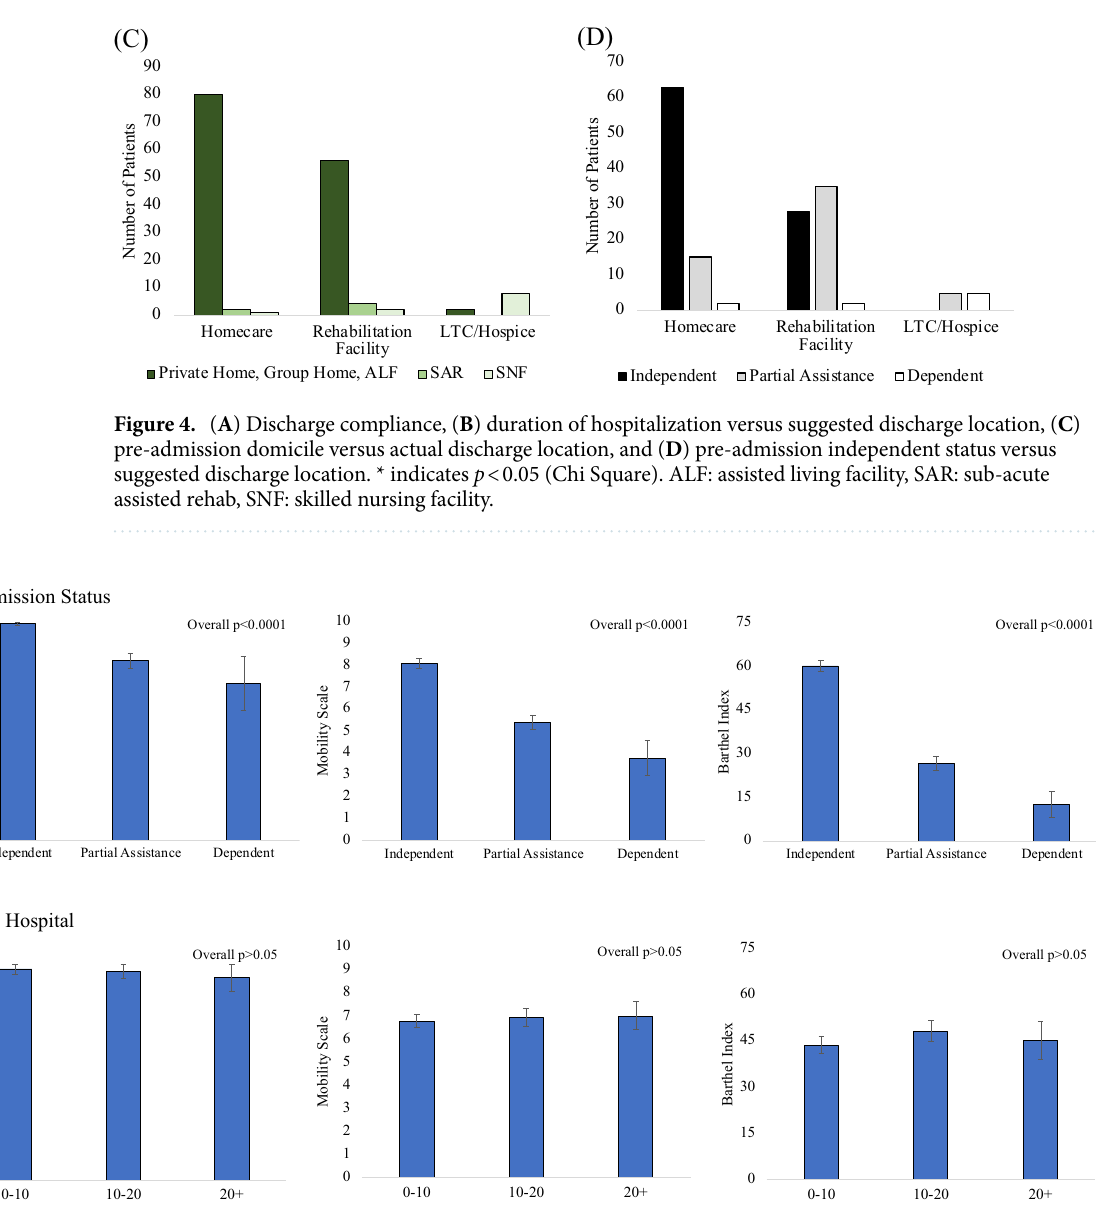
Figure 5. Modified Mental Status Score (range: 0–3), ICU Mobility Scale (range: 0–10), and modified Barthel Index (range: 0–75) for ( A ) pre-admission dependency status (overall p < 0.001, ANOVA) and ( B ) duration of hospitalization (overall p > 0.05,